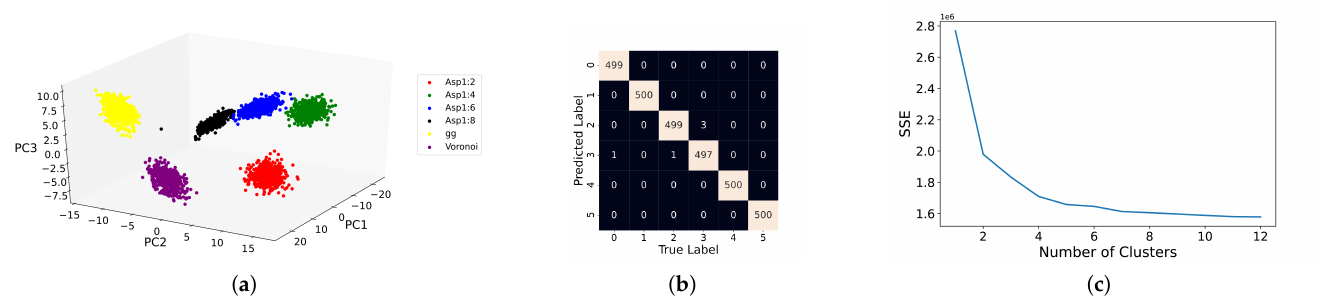
Figure 9. ( a ) 3D cluster plot showing predicted labels. ( b ) Confusion matrix between known labels and predicted labels for the 6 classes as performed by k -Means clustering with classification accuracy of 99.83 percent, ( c ) Elbow curve showing the variation of SSE as a function of number of clusters for selecting a suitable number of clusters in k -Means